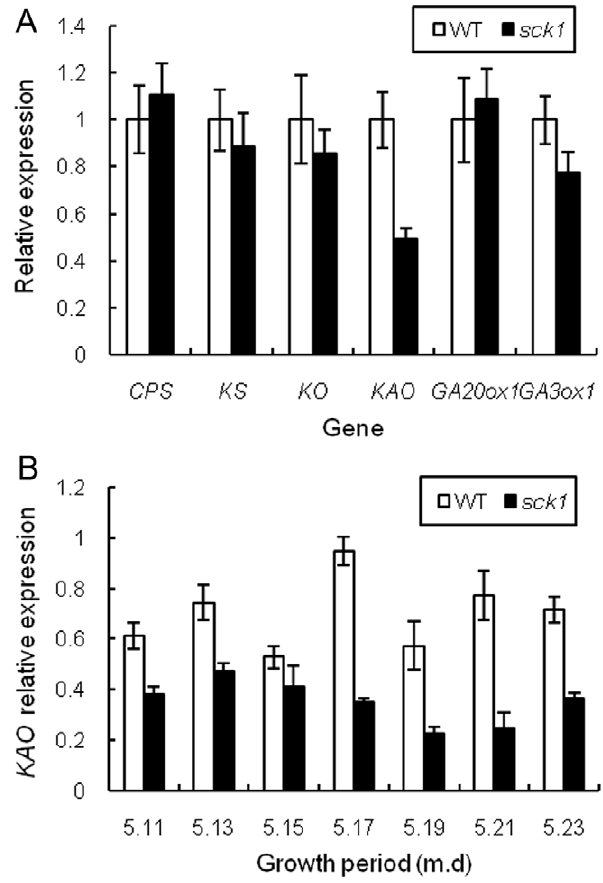
Figure 6. mRNA expression levels of genes involved in gibberellin biosynthetic pathway by real-time PCR. ( A ) mRNA expression levels of CPS , KS , KO , KAO , GA20ox1 and GA3ox1 involved in WT and sck1 determined by real-time PCR. The values are expressed relative to the level of transcripts in WT set to be one. ( B ) Comparison of relative expression of KAO between WT and sck1 . Catkins were gathered every two days during growth period in 2010 and the mRNA expression level was determined by RT-PCR. Data are means ( 6 SE, n=3).